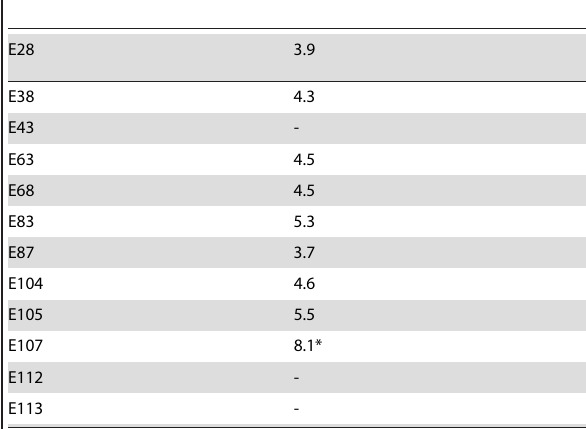
Table 1. pKa values of the glutamate residue side chains in the